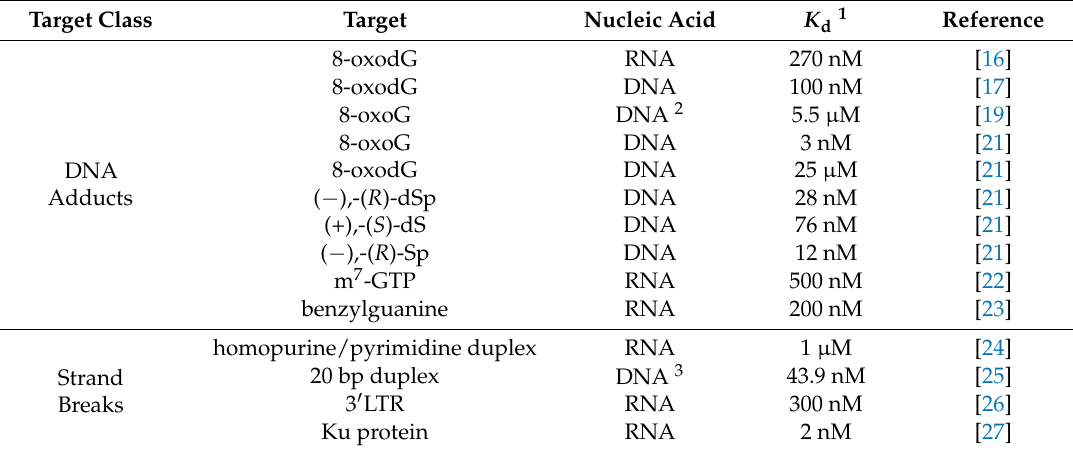
Figure 2. When guanine is oxidized, forming 8-oxoguanine (8-oxo-G), the resulting preferential basepairing to A ultimately leads to a G to T tranversion mutation. Further oxidation results in the spiroiminodihydantoin (Sp) adduct diastereomers, for example, which are highly destabilizing to the DNA duplex. Table 1. Aptamers for DNA damage and repair Table 1. Aptamers for DNA damage and repair targets.